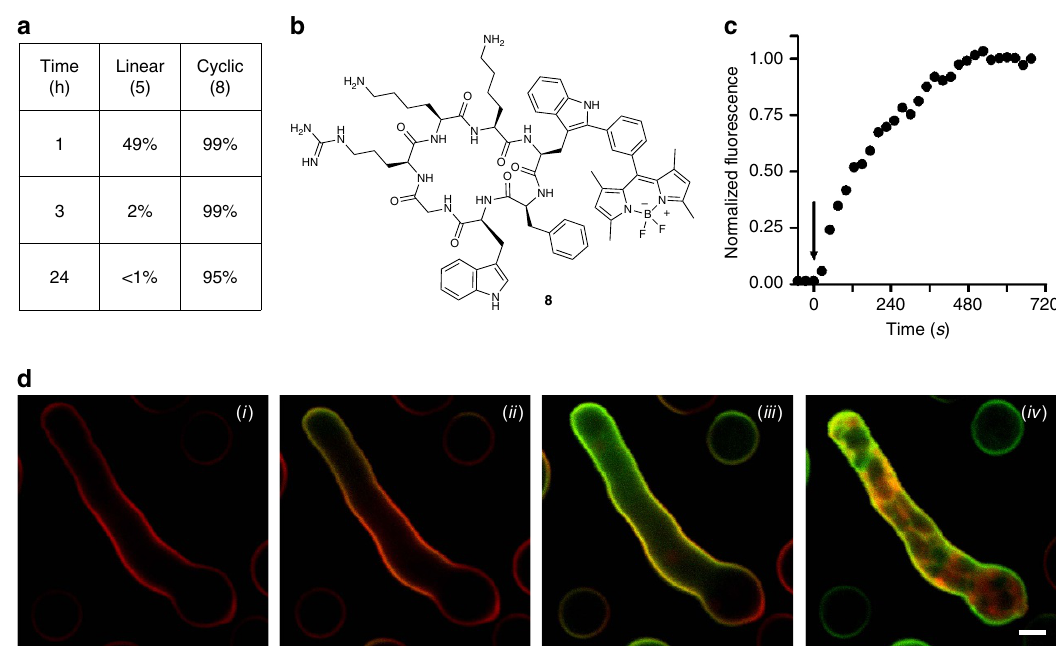
Figure 3 | The cyclic peptide 8 is a highly stable fluorogenic agent for high-resolution imaging of A. fumigatus . ( a ) Comparative chemical stability of mono-labelled BODIPY linear ( 5 ) and cyclic ( 8 ) PAF26 analogues in human bronchoalveolar lavage samples from patients with acute respiratory distress syndrome. ( b ) Chemical structure of the cyclic BODIPY-labelled peptide 8 . ( c ) Kinetic analysis (from time-lapse imaging in d of the fluorescence signal of compound 8 (2 m M) in the cell membrane of A. fumigatus (arrow points at the addition time for compound 8 ). ( d ) Time-lapse high-resolution imaging of A. fumigatus upon incubation with a cell membrane counterstain (red) and compound 8 (2 m M, green) for 0min ( i ), 1min ( ii ), 3min ( iii ) and 10min ( iv ) (see Supplementary Movie 3). Scale bar, 2.5 m m.